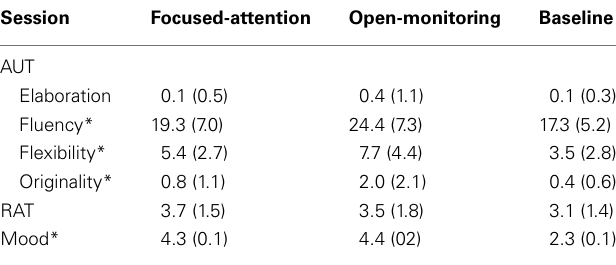
Table 1 | Means and SD for originality, fluency, flexibility, and elaboration scores from theAlternate UsesTask (AUT), the number of correct items from the RemoteAssociatesTask (RAT), and perceived mood ratings as a function of focused-attention training, Open-Monitoring training, and